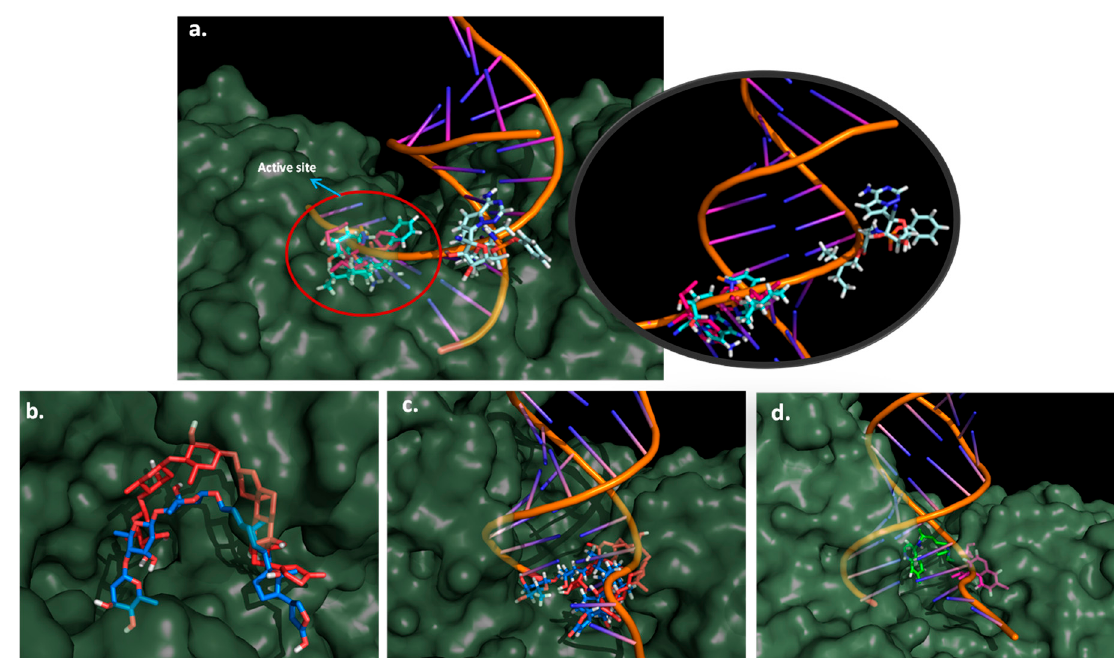
Figure 11. ( a ). Docking result (pink) and MD result (cyan) for the pose of remdesivir in RdRp-RNA complex. ( b ). Docking result (red) and MD result (blue) for the interaction of digoxin with RdRp active site. ( c ). RdRp-RNA complex overlapped to docking and MD results for digoxin. ( d ). RdRp-RNA complex overlapped to docking (pink) and MD (green) results for chloroquine.